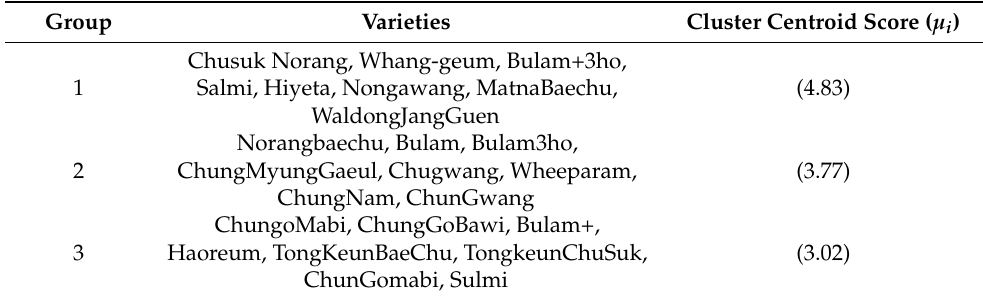
Table 3. Names of varieties for each cluster and values of cluster centroids for each cluster. Group Varieties